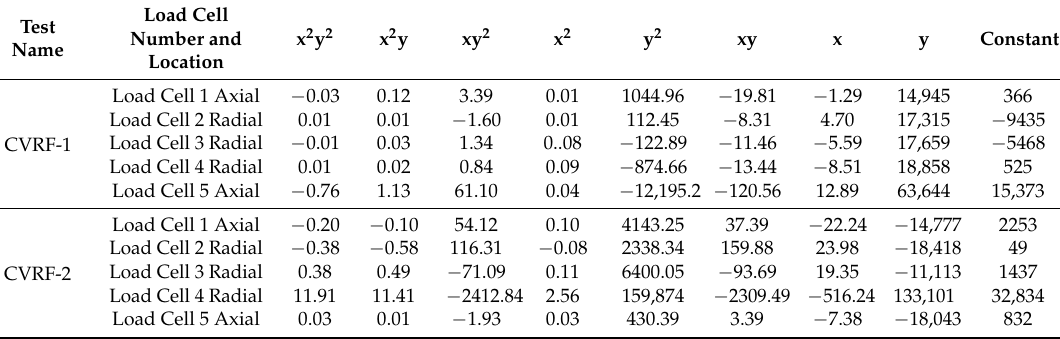
Table A1. Calibration coefficients for the relationship between the temperature, the load cell voltage and the calibrated